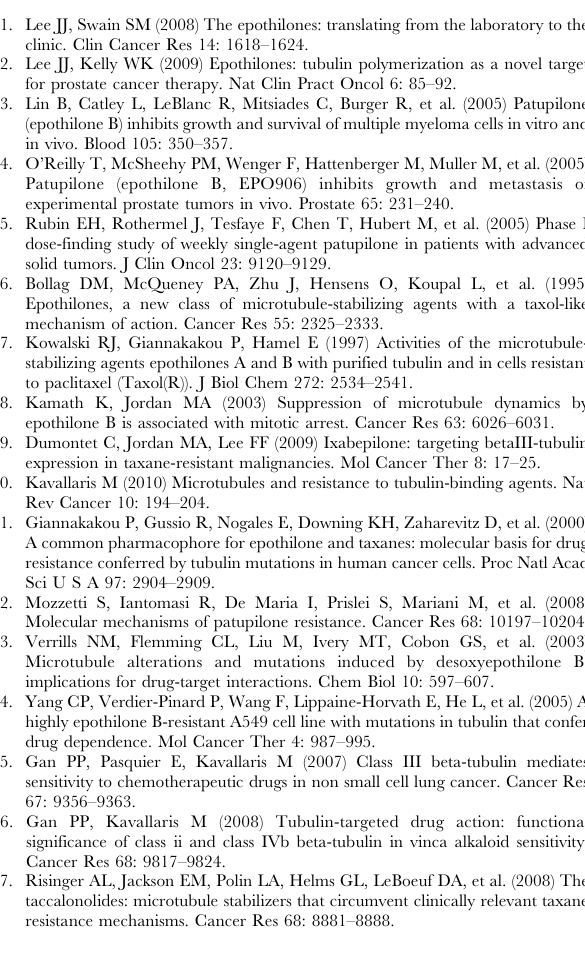
Figure S4 Sequence alignment of the b -subunit of 1TVK with the sequences of b IIb, b III and b IVb tubulin. Identical sequences are shaded grey, strong matching (dark blue), weak matching (light blue) and non matching residues are unshaded. The residues of the epothilone binding pocket (within 6 A˚ of the ligand) are highlighted in